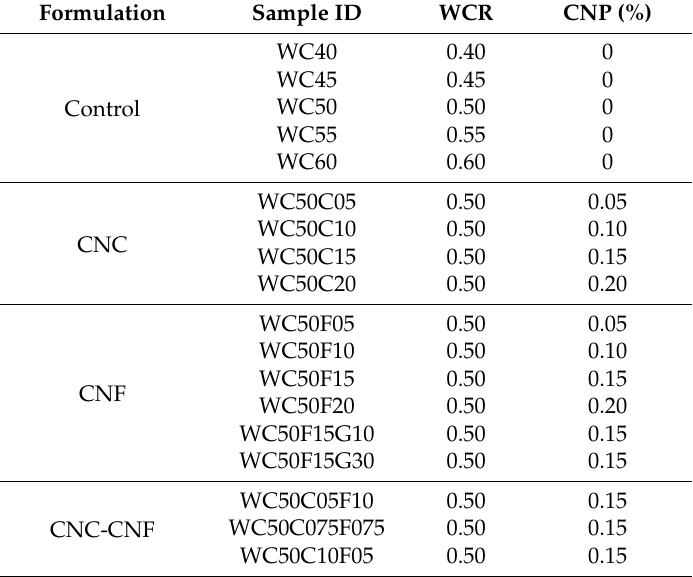
Table 1. Formulation of cement and cement- cellulose nanoparticles (CNP) pastes used in the study. Formulation Sample ID